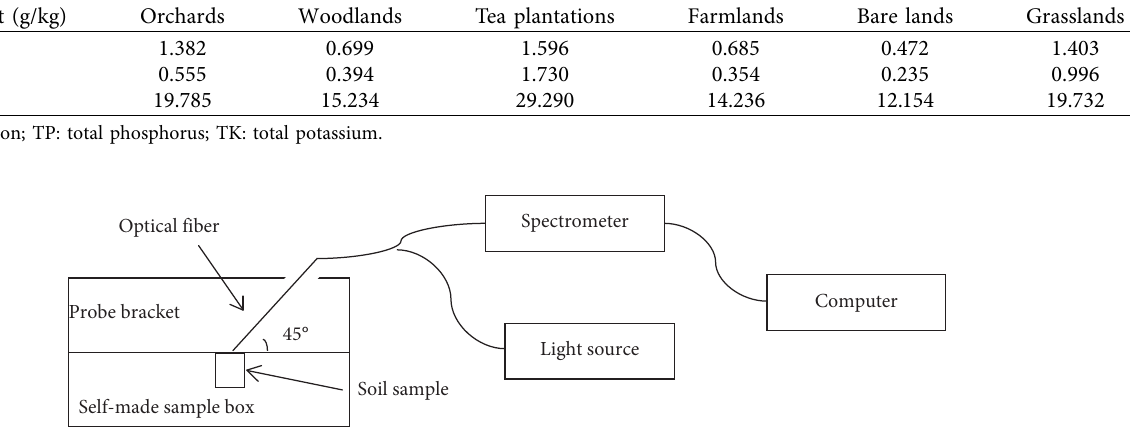
Figure 1: The schematic diagram of soil samples spectral measurement.